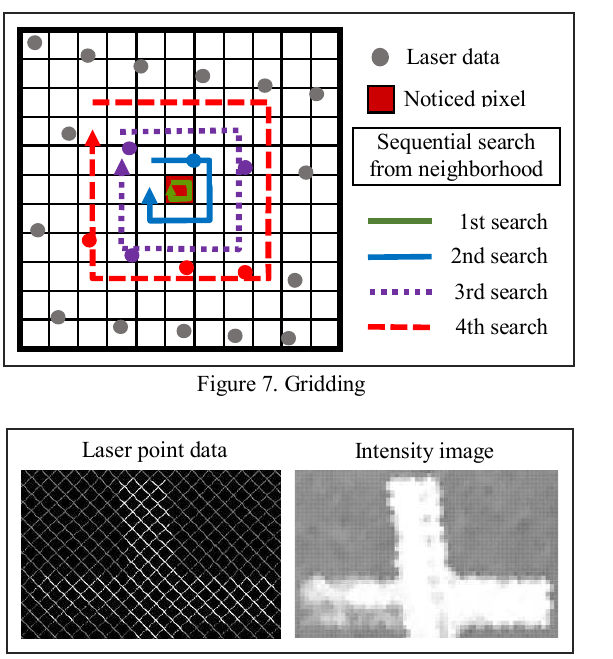
Figure 8. Comparison of laser data before and after